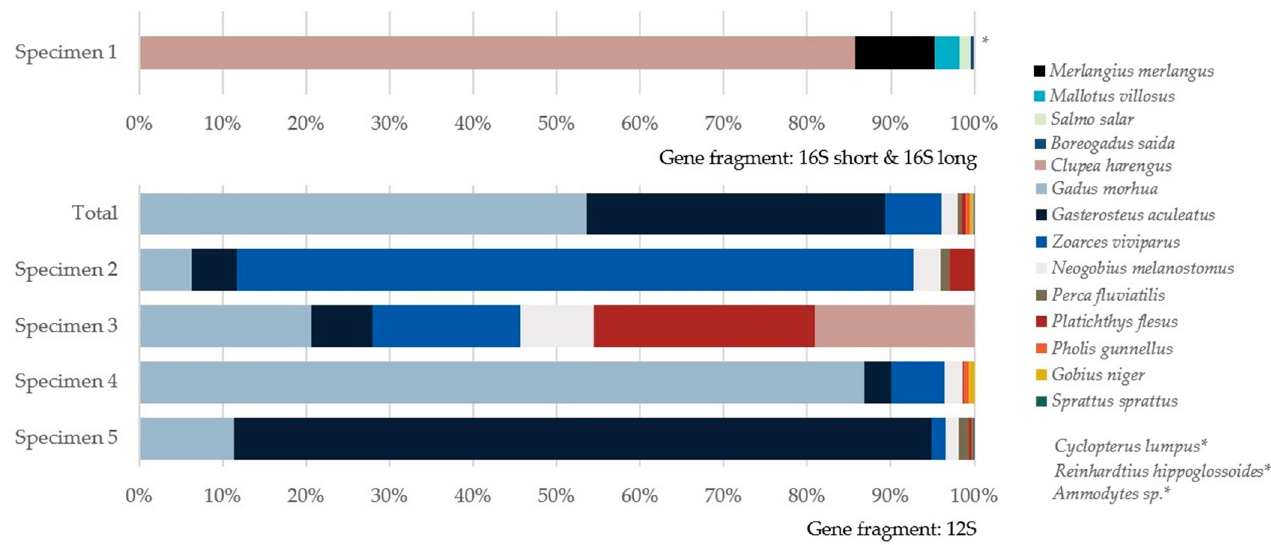
Figure 9. Overview of the eDNA-analysis results from the five Sowerby’s beaked whales ( Mesoplodon bidens ) that died in Swedish waters 2015–2020. The most common prey species were Atlantic herring ( Clupea harengus ), European eelpout ( Zoares viviparus ), cod ( Gadus morhua ) and three-spined stickleback ( Gasterosteus aculeatus ). The results from Specimen 1 are separated from Specimens 2 to 5 because different gene fragments were analyzed. *Traces of species detected.